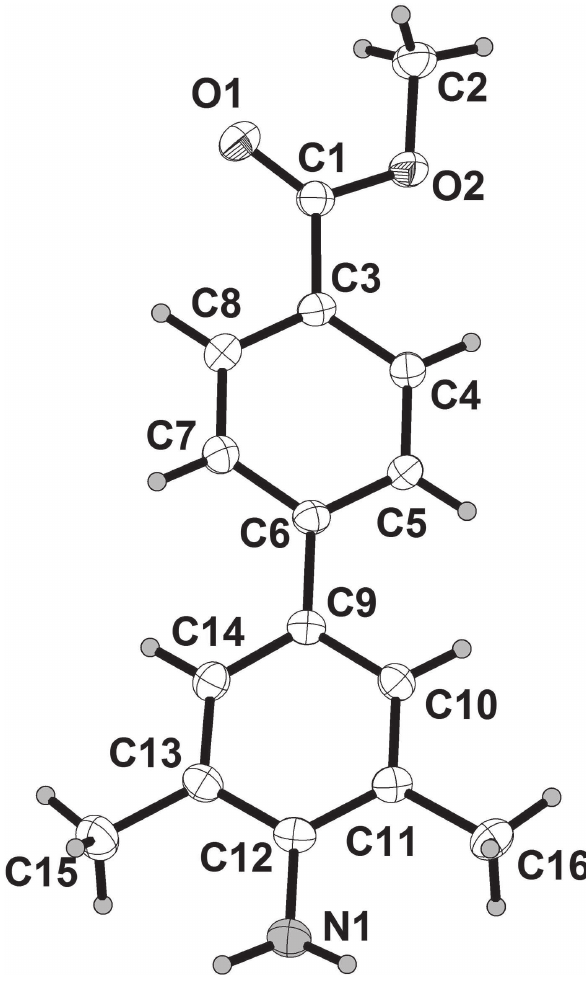
The asymmetric unit of the title crystal structure is shown in the figure. Tables 1 and 2 contain details on crystal structure and measurement conditions and a list of the atoms including atomic coordinates and displacement parameters.